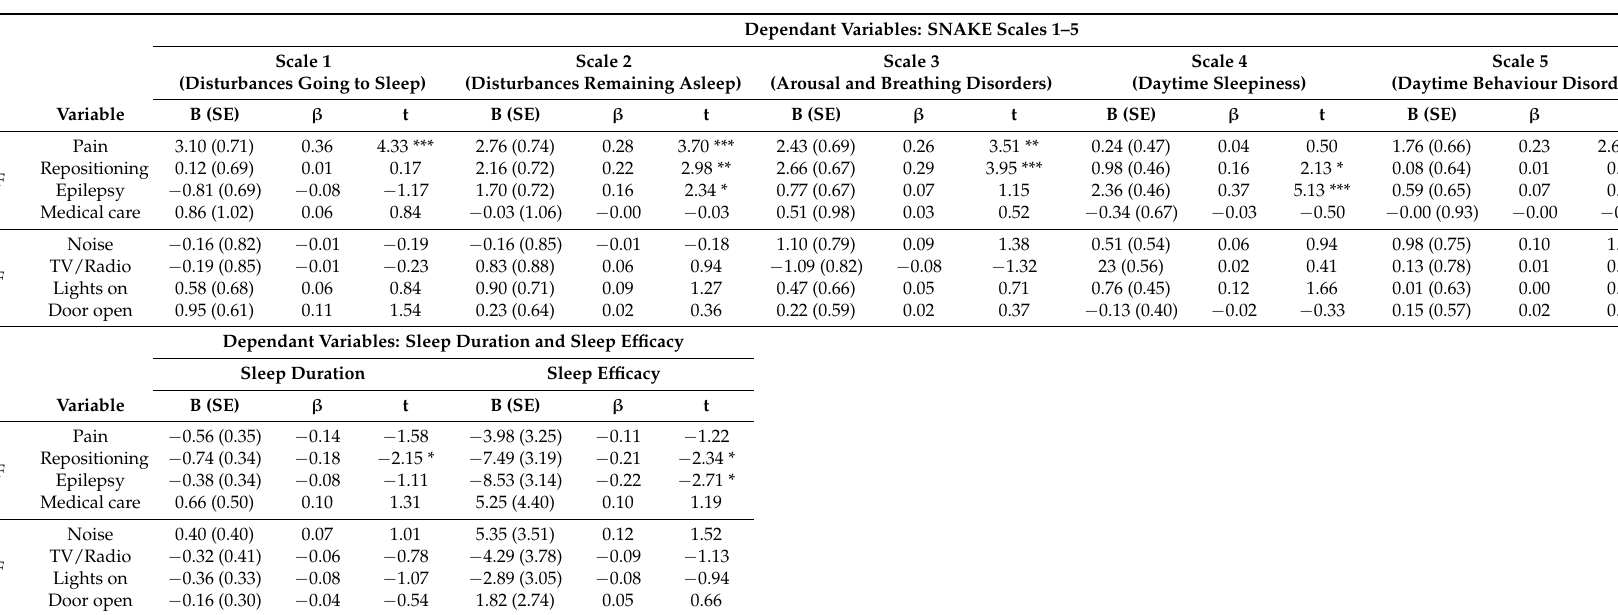
Table 2. Linear regression analyses with CRF and ERF as independent variables and “Sleep Questionnaire for Children with Severe Psychomotor Impairment” (SNAKE) scales, sleep duration, and sleep efficacy as dependent